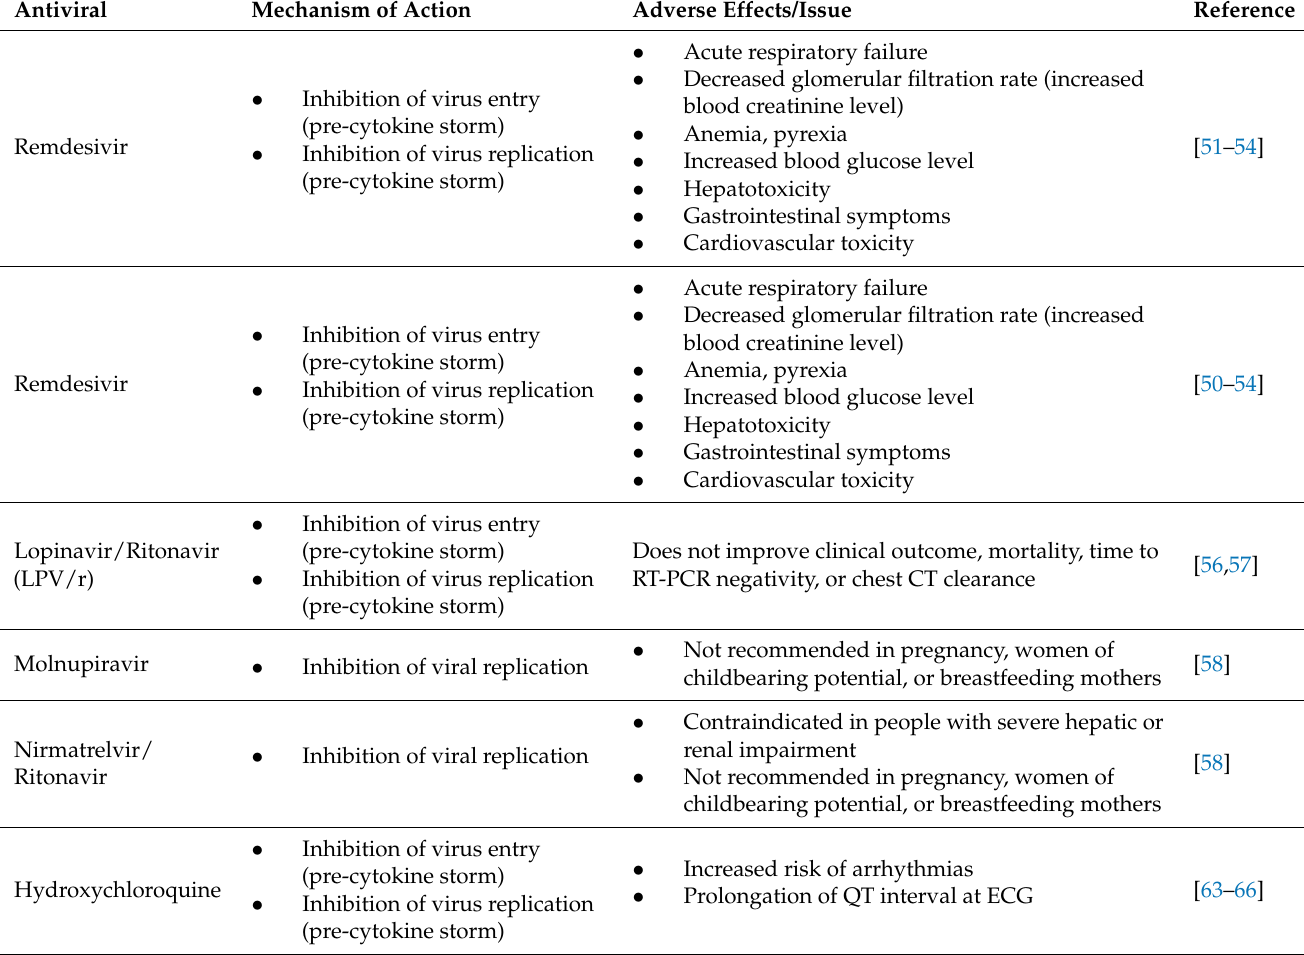
Table 1. Antiviral treatments against